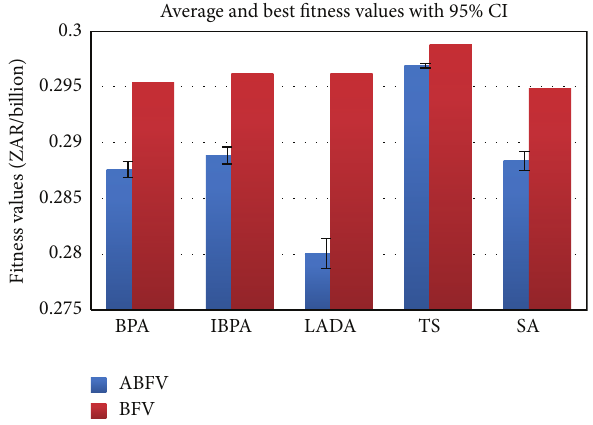
Figure 3: A comparison of each algorithm best and average fitness values determined along with the 95% CI